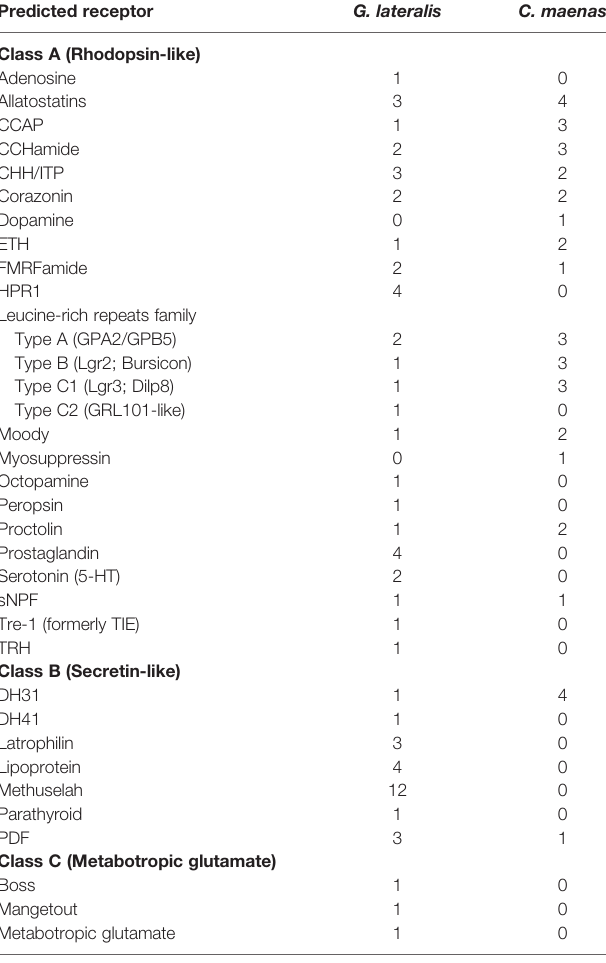
TABLE 2 | Classi fi cation and number of contigs encoding G protein-coupled receptors in the Gecarcinus lateralis and Carcinus maenas Y-organ transcriptomes. Predicted